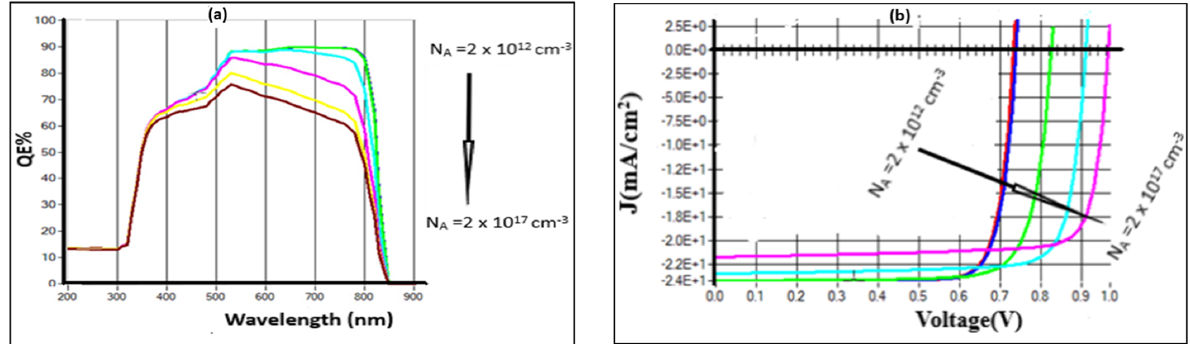
Figure 5. ( a ) Spectral response of the enhanced quantum efficiency ( QE ) at longer wavelength and ( b ) J–V current curves for the cell with the increase of acceptor carrier concentration ( N A ).